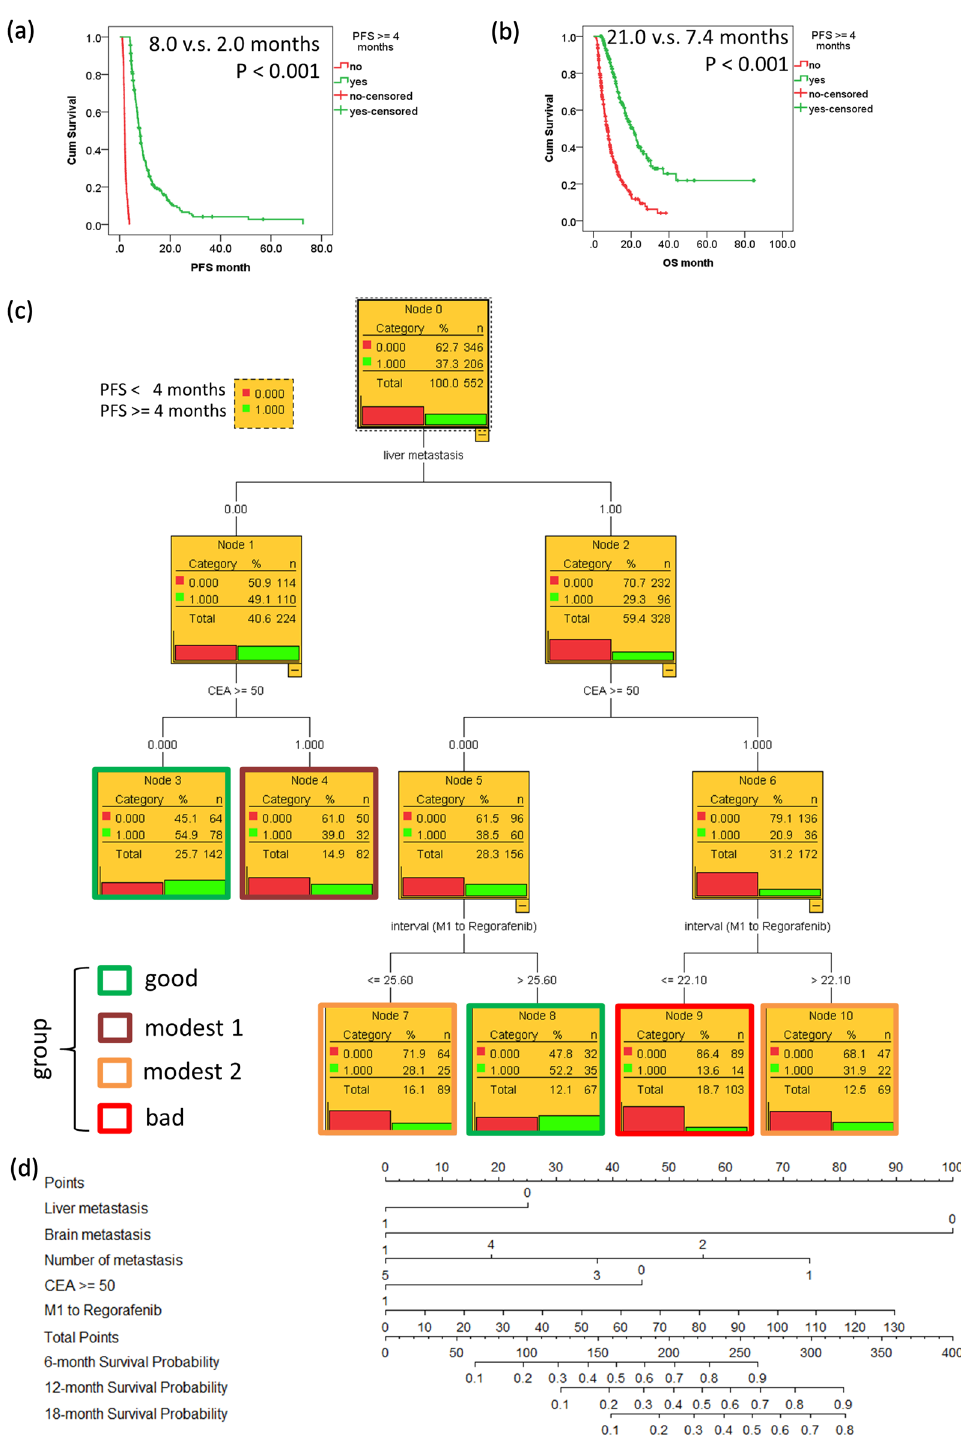
Figure 5. Kaplan–Meier curves for ( a ) progression-free survival (PFS); ( b ) overall survival (OS) by patient with PFS > = 4 months or not. ( c ) The decision tree in predicating the priority right of regorafenib for the treatment of refractory metastatic colorectal cancer according to liver metastasis, CEA, and interval between M1 and regorafenib. ( d ) The prognostic nomogram for OS of patients after